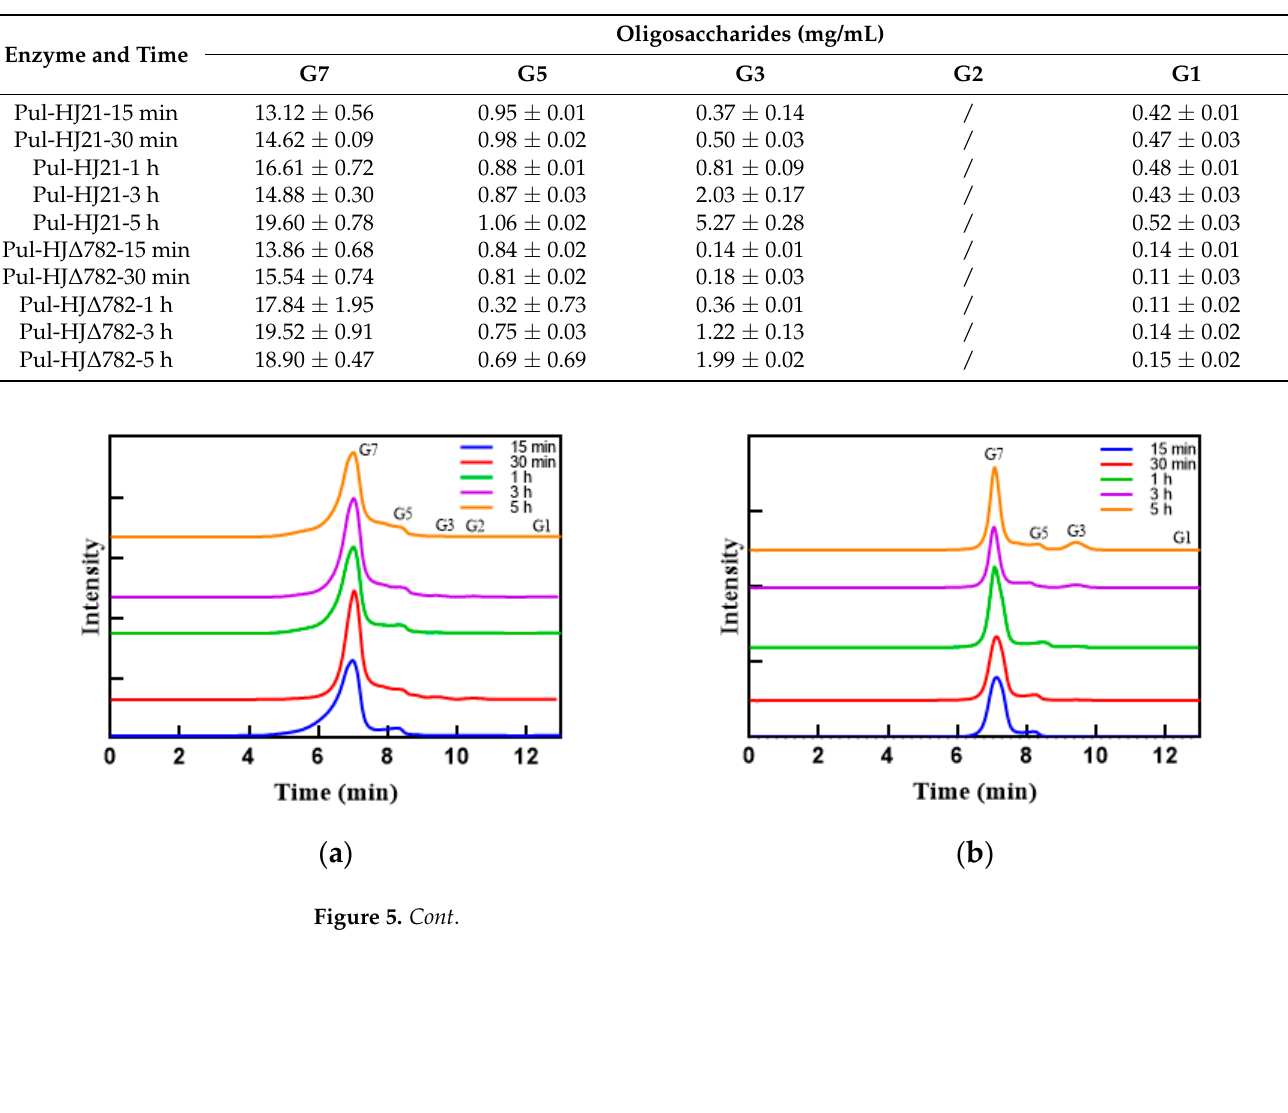
Table 4. Concentration of hydrolysates after the enzymatic digestion of pullulan at different times by Pul-HJ21 and Pul-HJ ∆ 782.